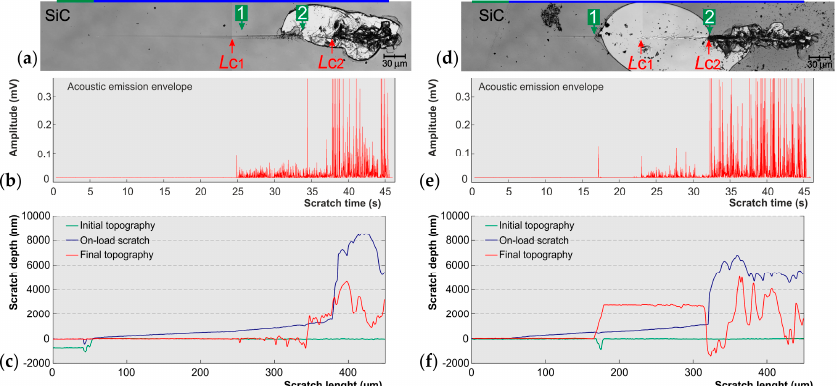
Figure 3. Advanced analysis of two ramped scratch tests on 00SiC sample with ( a , d ) the microscopic records, ( b , e ) the acoustic emissions records and ( c , f ) depth change records.